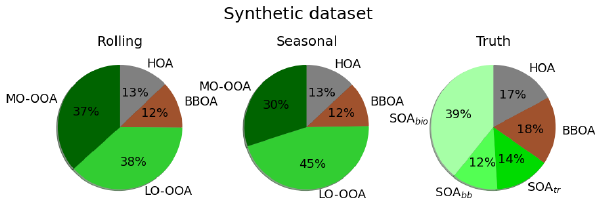
Figure 1. OA apportionment results for rolling and seasonal meth- ods and truth